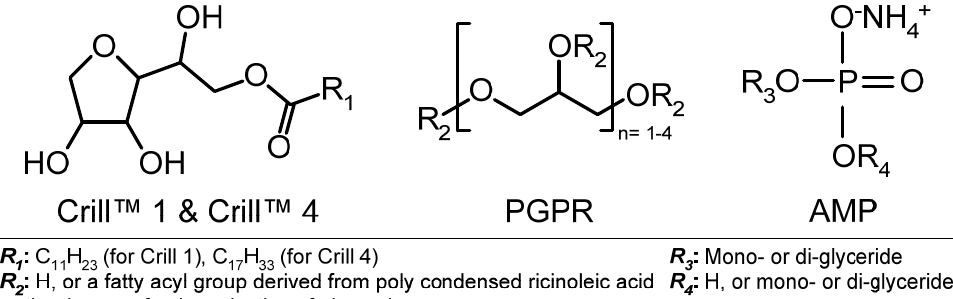
Figure 1. The chemical structure of the emulsifiers used in the study (Crill™ 1 (sorbitan monolaurate), Crill™ 4 (sorbitan monooleate), PGPR 4150 (polyglycerol polyricinoleate), and AMP 4455 (ammonium phosphatide).